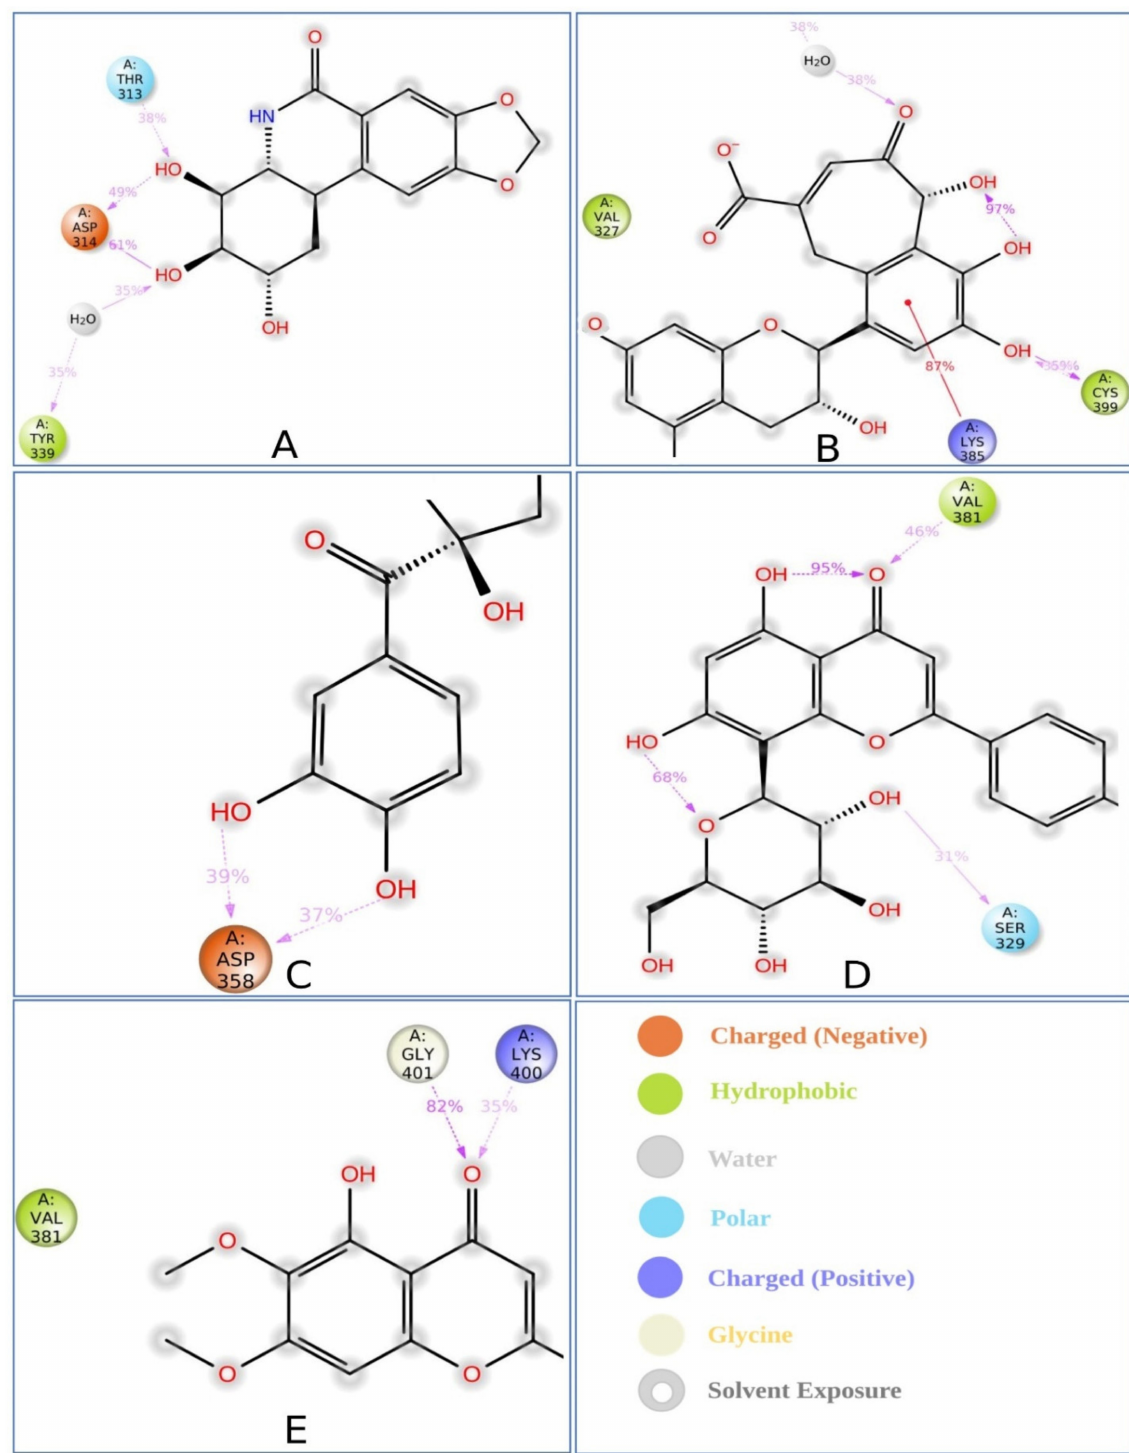
Figure 6. Schematic representation of interactions of selected ligand atoms with MCPyV LT protein residues shown for interactions that occur more than 30.0% of the simulation time between the protein and the compounds ( A ) P CID: 73065, ( B ) CID: 3084131, ( C ) CID: 11537736, ( D ) CID: 21629801, and ( E ) CID: 162464 in the selected trajectory (0.00 through 250.00